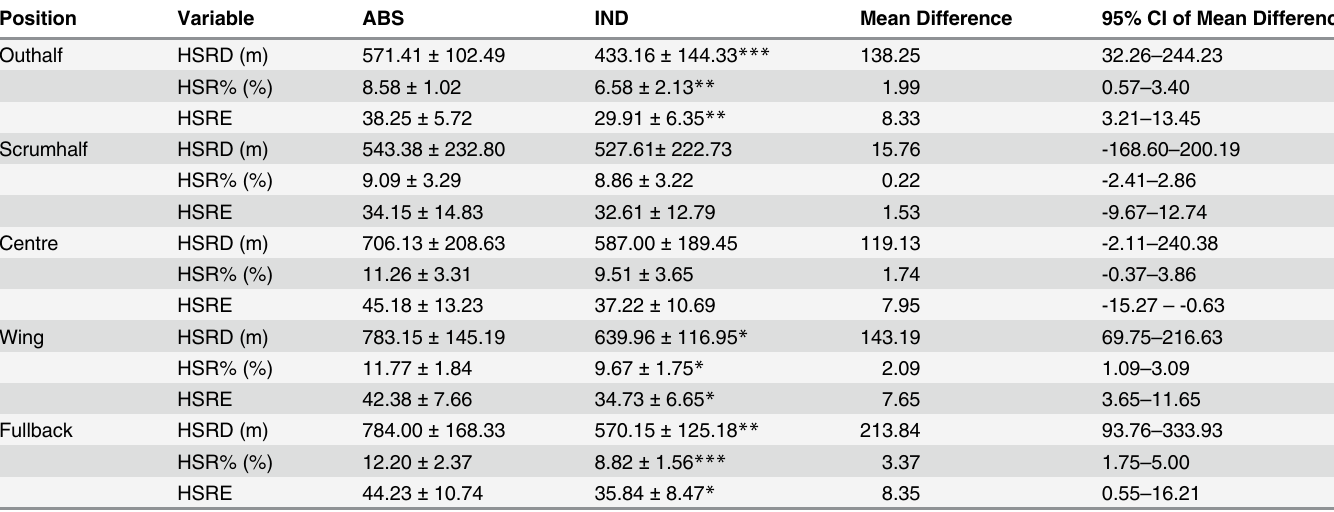
Table 6. ABS vs IND HSR demands of back position